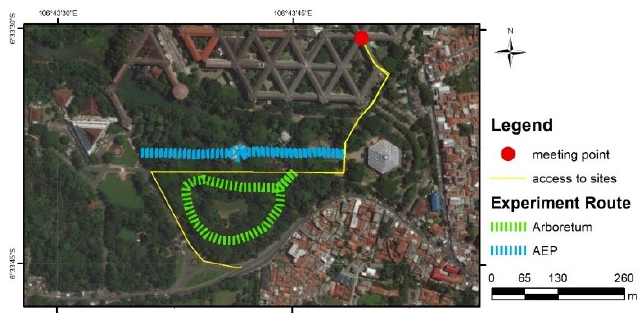
Figure 1. Experimental Route.